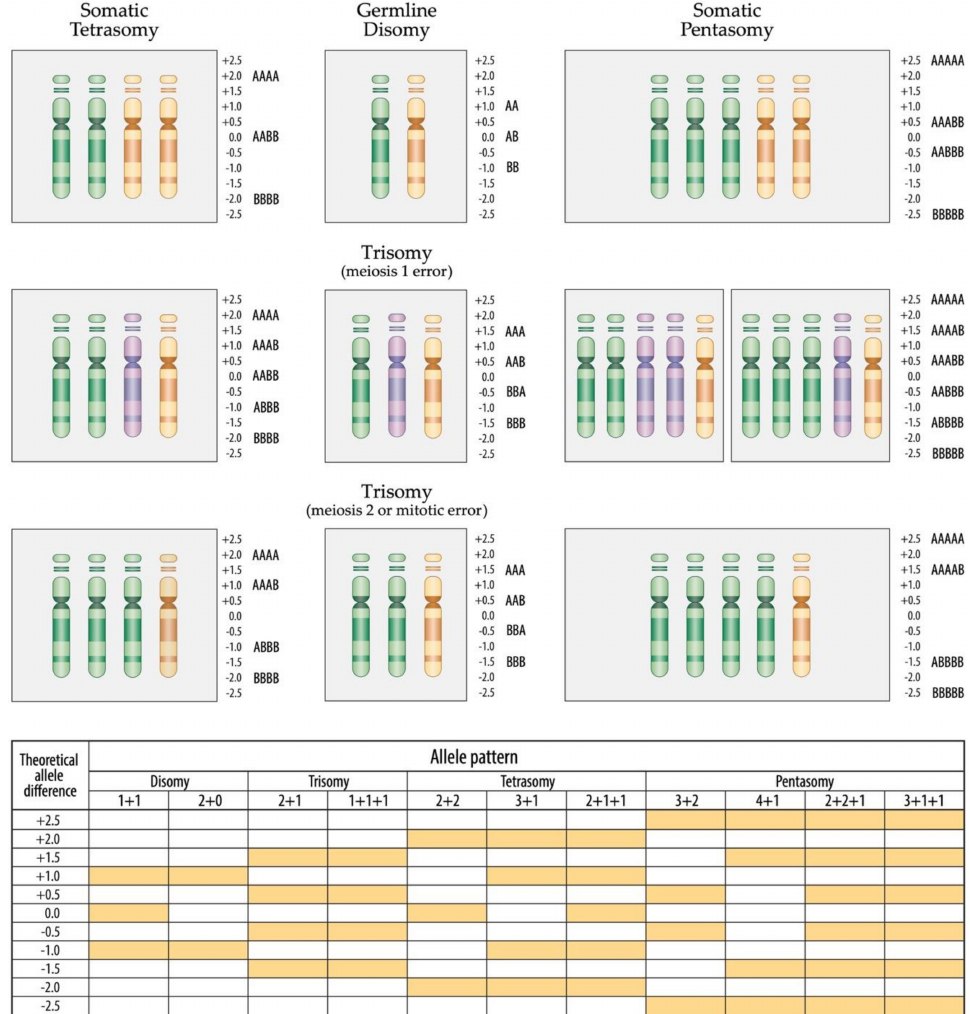
Figure 7. Schematic overview of chromosome 21 homologue and corresponding allele distribution patterns in tetra- and pentasomic hyperdiploid leukemias in constitutionally disomic and trisomic cases, respectively. Only one example of the various possible permutations of homologue distributions is shown in each instance. All variants of tetra- and pentasomies in constitutional disomic or trisomic individuals that result from a meiosis 2 or mitotic error, produce identical allele distribution patterns, in case of tetrasomies either a "2 + 2” or “3 + 1” and in case of pentasomies a "3 + 2” or “4 + 1” one. By far the vast majority of tetrasomies derive from the duplication of both parental homologues (“2 + 2”) in both constitutional disomic as well as trisomic cases, whereas the alternative “3 + 1” pattern is much rarer [17,51]. The same applies also to pentasomies: a “3 + 2” is significantly more common than a “4 + 1” pattern. Of particular interest are those tetra- and pentasomic leukemias that indeed contain three distinct alleles, which can only be found in constitutional trisomic individuals who emerge from a meiosis 1 error. Such tetrasomies can thus only have a “2 + 1 + 1” and pentasomies only a “2 + 2 + 1” or 3 + 1 + 1 combination of homologues, respectively. The scale of the allele difference on the side of the ideograms as well as the one displayed in the schematic layout on the bottom of the figure can only be taken as a mathematically determined optimum. As becomes especially evident in all the array images that derive from increased copy number alterations, such a theoretical optimum can in practice never be achieved. In truth, one has always to keep in mind that the allele difference as well as the Log2 ratio will never reach the mathematically expected amplitude, because its height will always depend on and be compressed by a variety of factors, including the technical quality of the hybridization, the applied computational algorithm, the respective copy number, the clonal composition of the investigated sample as well as the respective genotype configuration. The respective allele distribution pattern together with the obtained copy number per se, in contrast, delivers a much more accurate and reliable information